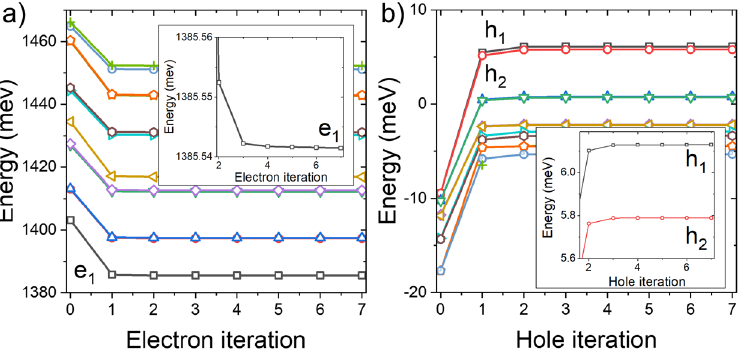
Figure 3. Several lowest electron ( a ) and hole ( b ) states energies, for a CPQD of H = 4 nm and D = 23.5 nm, during the self-consistent treatment of electron-hole interaction. The rapid initial step is due to the inclusion of interaction (as compared to the non-interacting zeroth iteration). Then the process converges rapidly. The inset shows the magnification of the evolution for the ground electron level ( e 1 ) and the first two lowest hole states ( h 1 / h 2